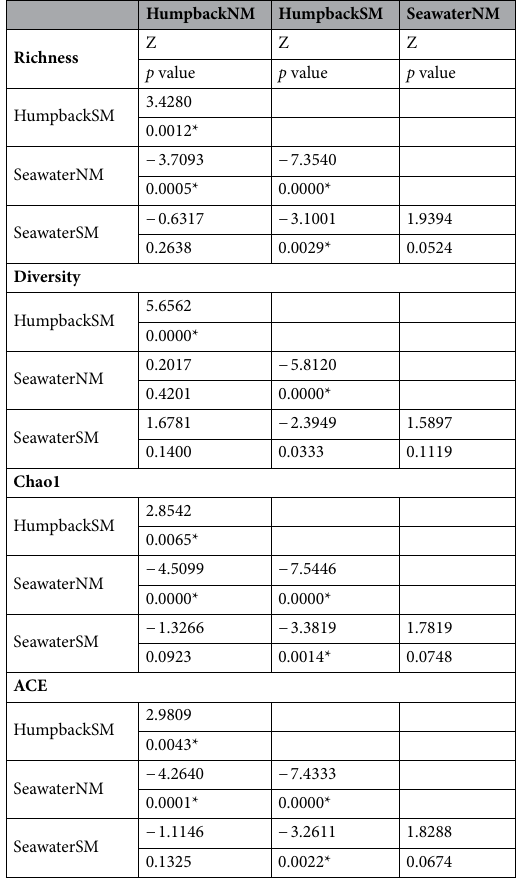
Table 2. Z and p values of Kruskal–Wallis test of richness, Shannon–Wiener diversity, Chao1 and ACE species estimator of rarefied counts. The upper value is the Z, the lower the p value in each cell. Those p values with an asterisk are statistically